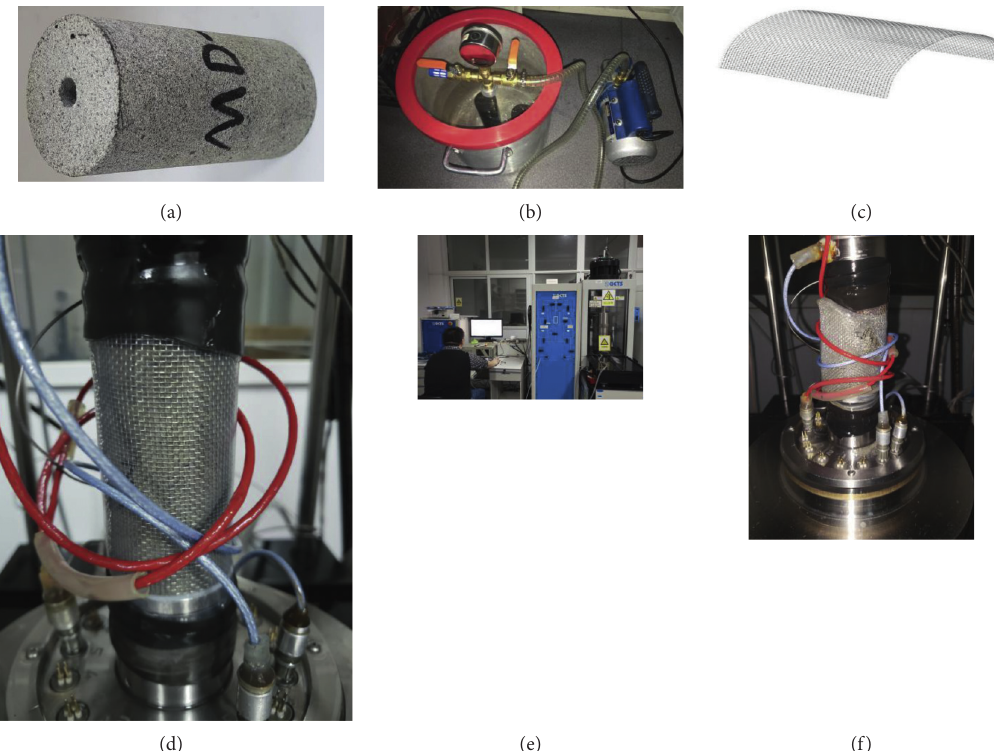
Figure 2: Diagram before and after the horizontal penetration test sample. (a) Pre-experiment (rock samples). (b) Pre-experiment (saturation device). (c) Pre-experiment (steel wire mesh). (d) Pre-experiment. (e) During experiment. (f) After completion of